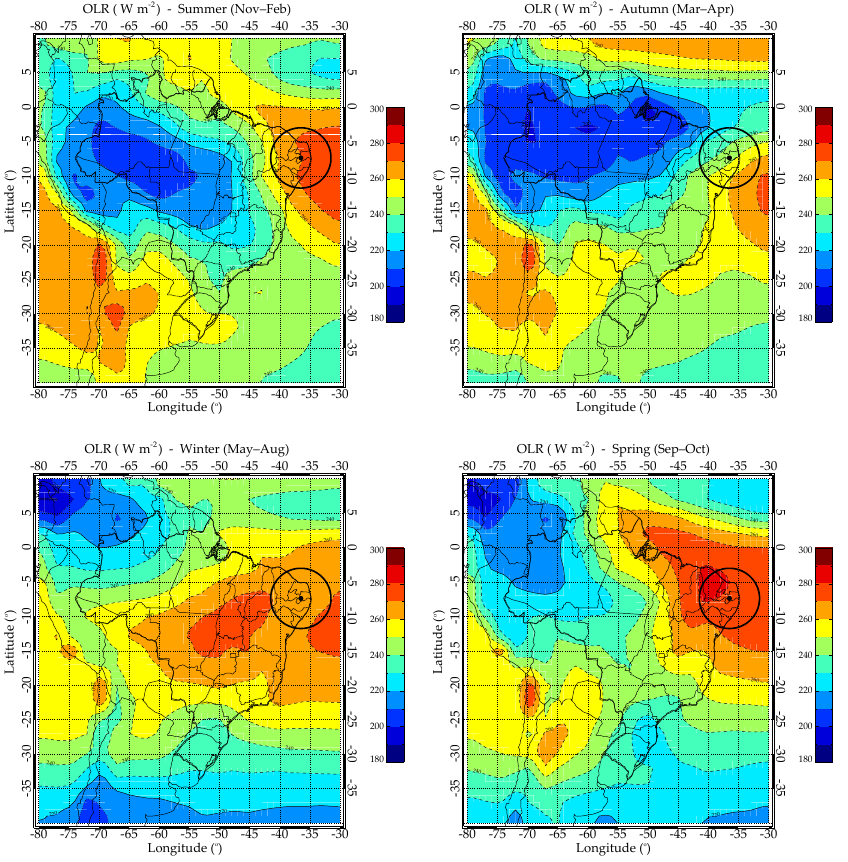
Figure 11. Seasonal variation in 11 years of daily mean of outgoing longwave radiation (OLR) over South